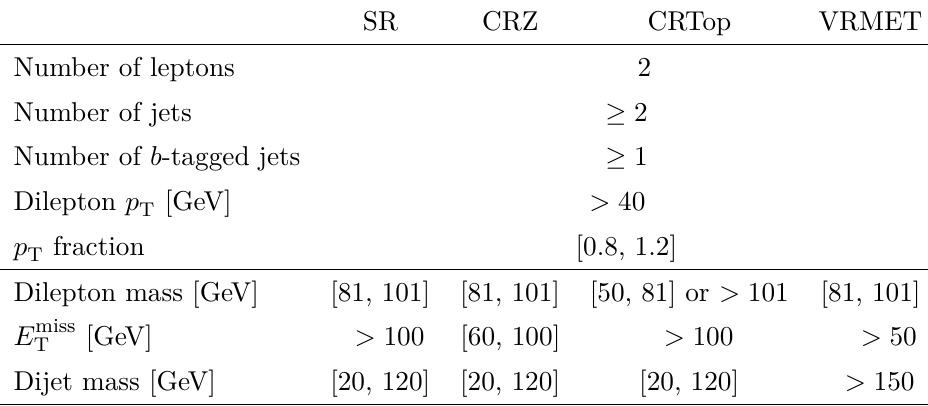
modelling in Z+HF events T